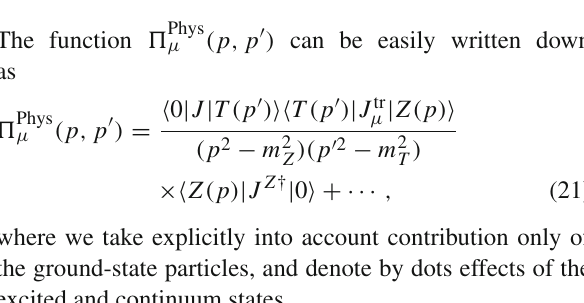
Fig. 2 The same as in Fig. 1, but for the coupling f T of the state